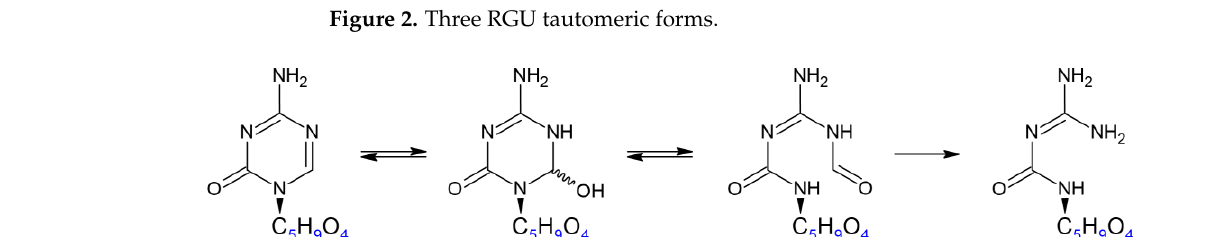
Figure 3. Path for 5-azacytidine hydrolysis proposed by Notari and Chan with carbinolamine intermediate formation, which is slow at neutral pH.